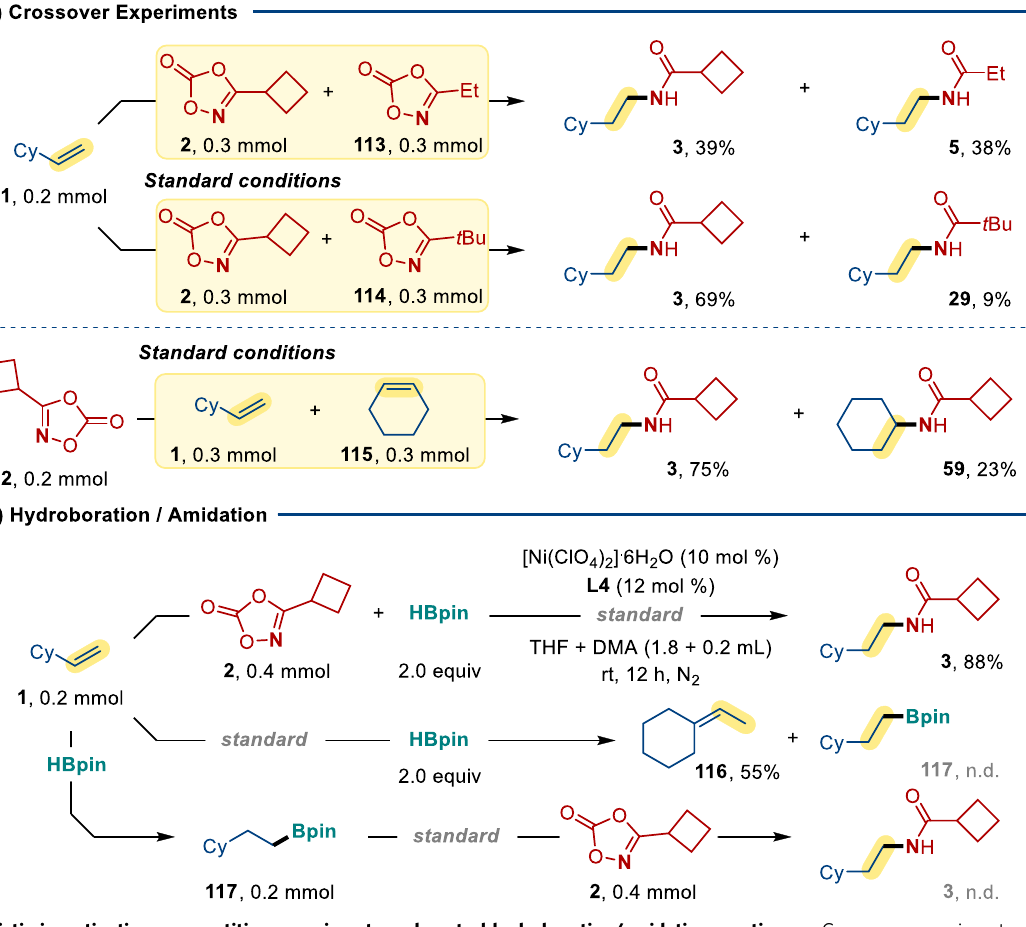
Fig. 6 Mechanistic investigation — competition experiments and control hydroboration/amidation reactions. a Crossover experiments. b Hydroboration/amidation. Standard conditions: [Ni(ClO 4 ) 2 ] ∙ 6H 2 O (10 mol %), L4 (12 mol %), HBpin (2.0 equiv), THF + DMA (1.8 + 0.2 ml), in N 2 at room temperature for 12 h. The yields presented in part a are all isolated yield. The yield of 3 presented in part b is NMR yield. The yield of 116 presented in part b is GC